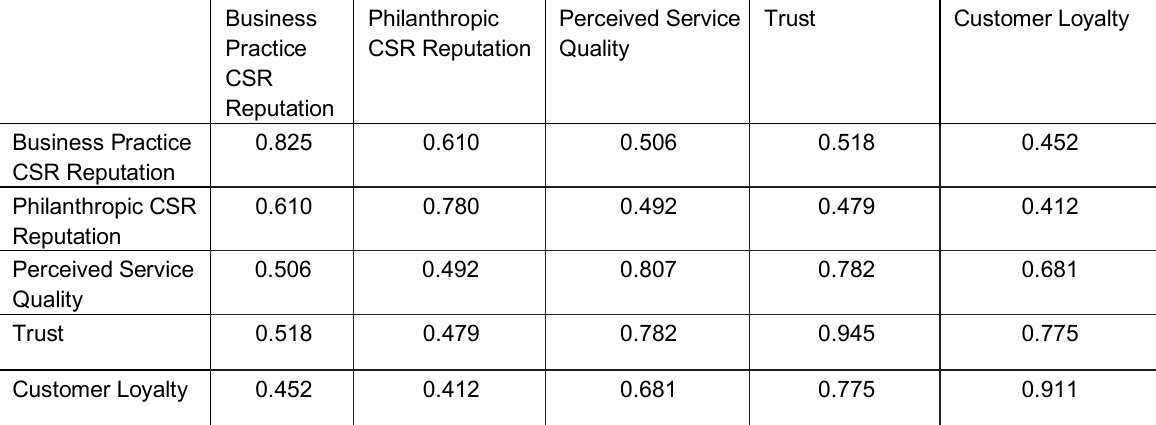
Table 3: Correlations among latent variables with AVE’s square